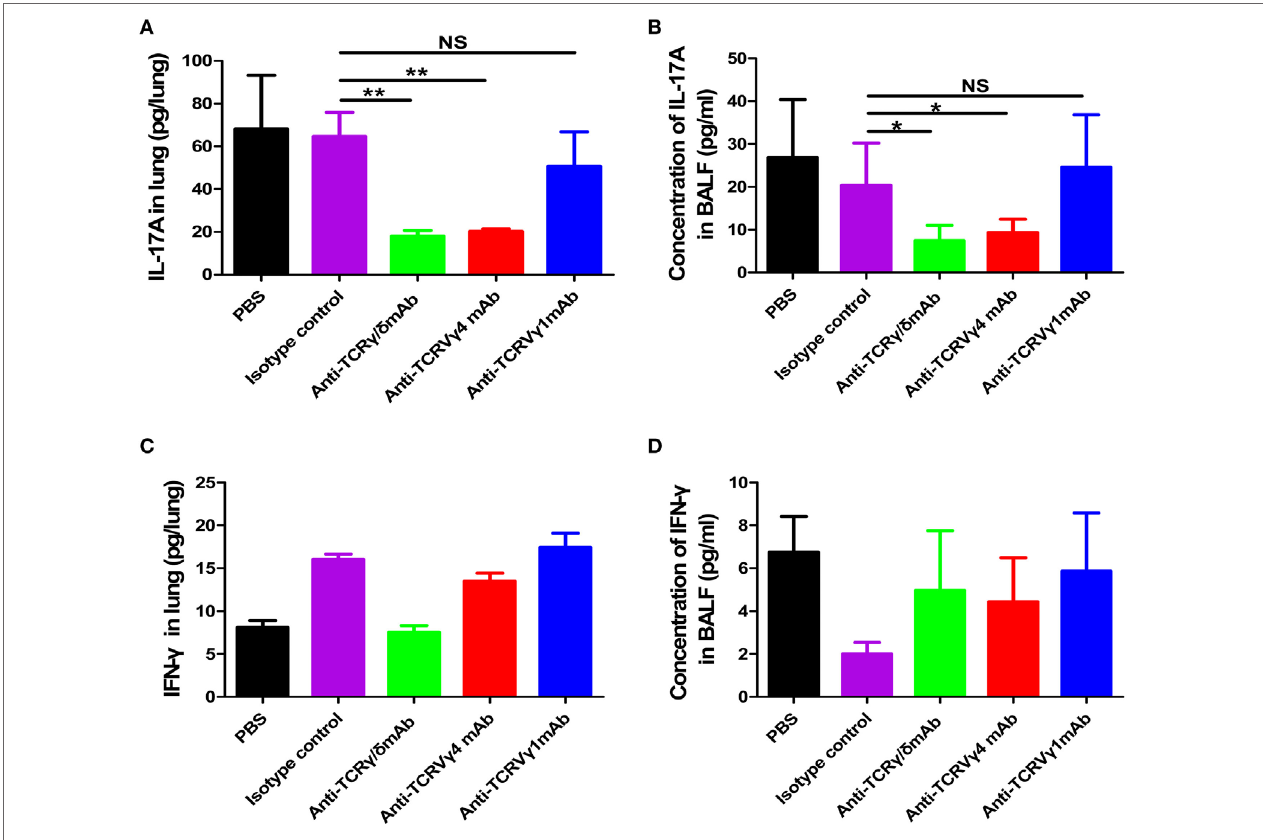
FigUre 9 | Reduced IL-17A secretion in γδ T cells and V γ 4 + γδ T subset depletion groups. The amount of IL-17A (a) or IFN- γ (c) in lung and the concentration of IL-17A (B) or IFN- γ (D) in BALF from the PBS control group, isotype antibody control group, γδ T cell depletion group, V γ 1 + γδ T cell depletion group, and V γ 4 + γδ T cell depletion group were quantified using ELISA at 1 dpi. ** p < 0.01. NS, not